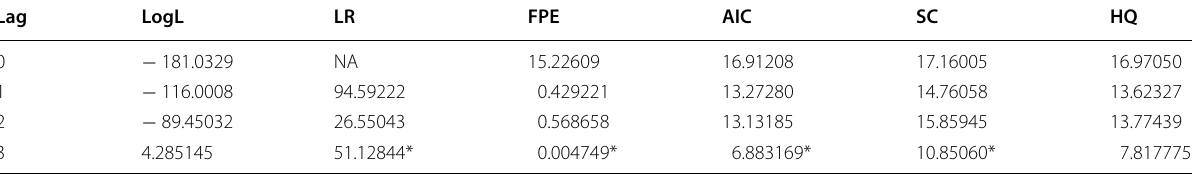
* indicates lag order selected by the criterion